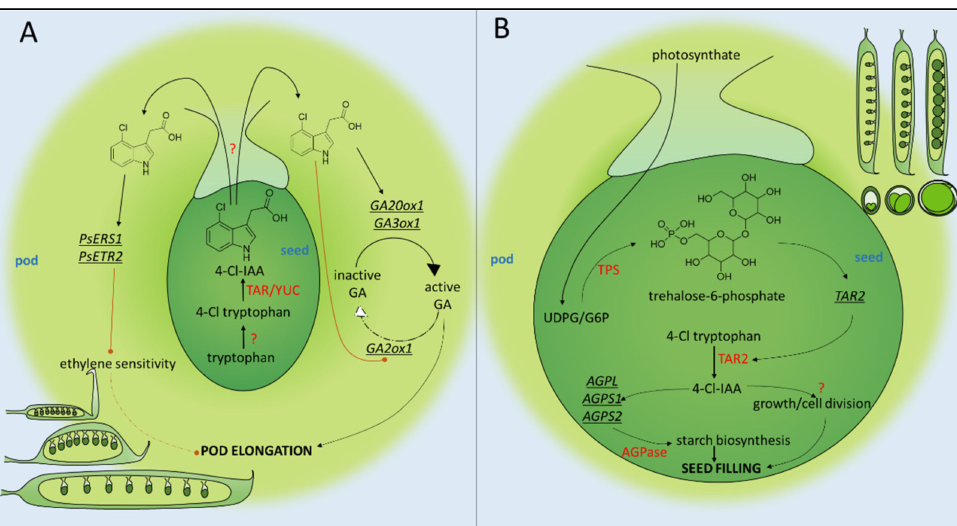
Figure 1. Schematic representation of pod elongation ( A ) and seed filling ( B ) stages of pea reproduc- tive development. 4-Cl-IAA, 4-chloroindole-3-acetic acid; TAR, tryptophan aminotransferase related; YUC, yucca; GA, gibberellic acid; GAox, gibberellic acid oxidase; ERS1, ethylene response sensor 1; ETR1, ethylene receptor 1; UDPG, uridine diphosphate glucose; G6P, glucose-6-phosphate; TPS, trehalose phosphate synthase; AGPase, adenosine diphosphate glucose pyrophosphorylase.